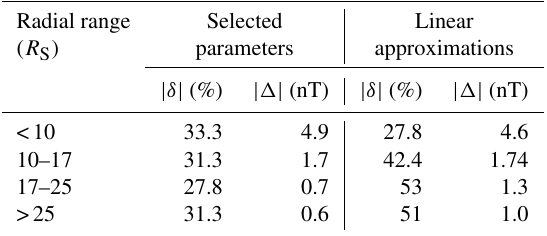
Table 4. Mean values of the absolute | (cid:49) | and relative | δ | fit errors for the inbound and outbound passes of Revs 17–19, 145, 146, and 163 in four radial ranges, for both selected and linear approximation parameters. Radial